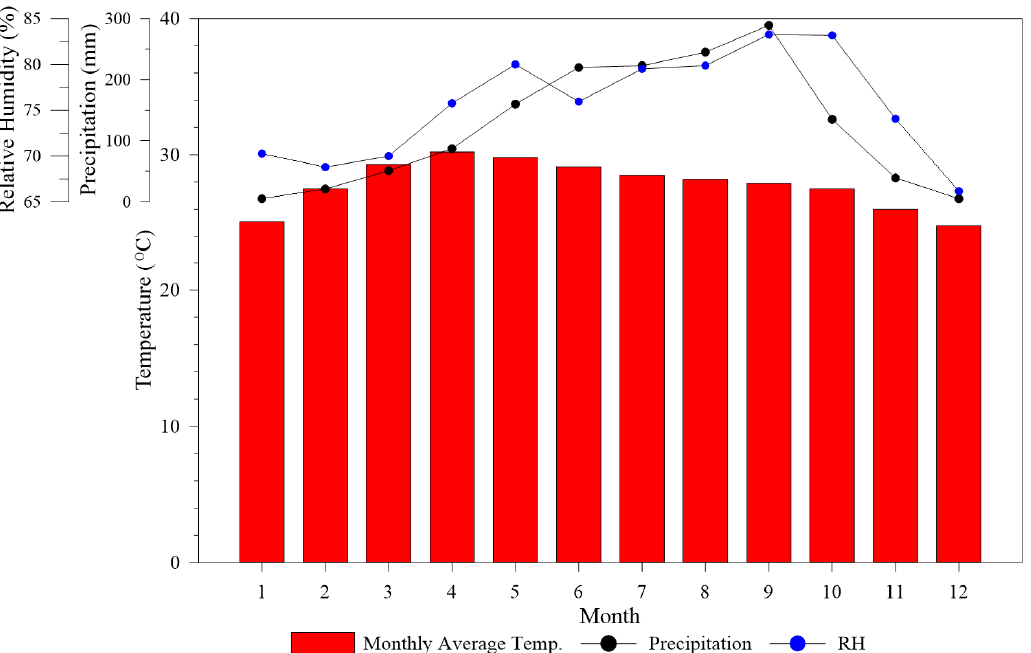
Figure 9. Annual variations of temperature, precipitation, and relative humidity at Saraburi.